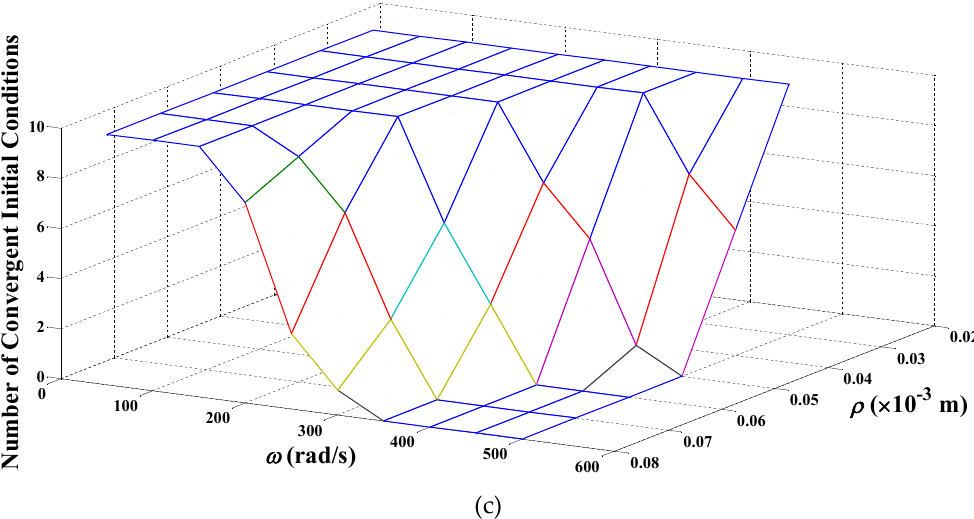
Figure 6. Convergence of response for initial conditions, x 0 = y 0 = 0.01 : 0.01 : 0.10 mm: ( a ) PD controller, ( b ) FLC, ( c ) FBBRC.